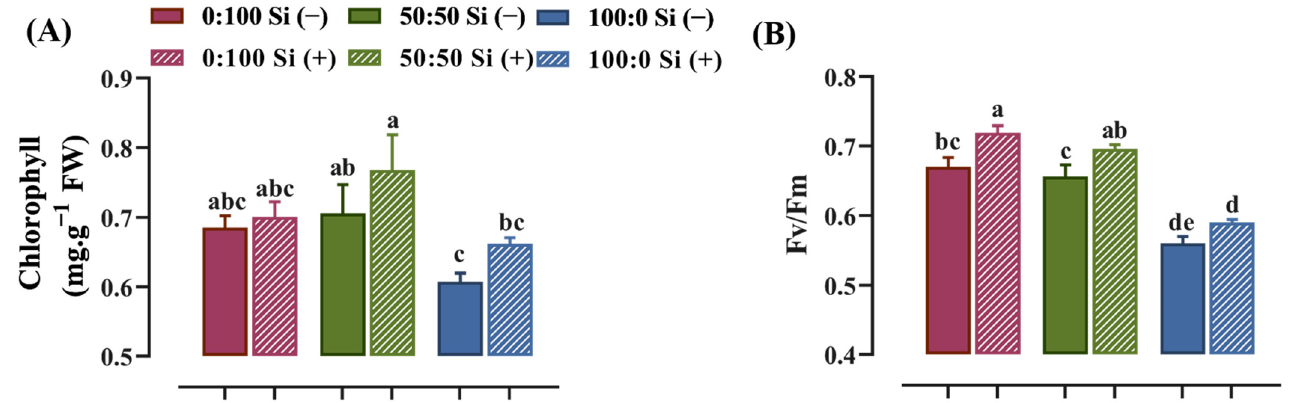
Figure 3. Photosynthetic capacity as characterized by ( A ) chlorophyll content and ( B ) Fv/Fm value in response to N forms with or without Si supplementation. Data are given as the mean ± standard deviation (SD) of n ≥ 4 replicates. Different lowercase letters over bars indicate statistical significance according to Duncan’s multiple range test at p = 0.05.